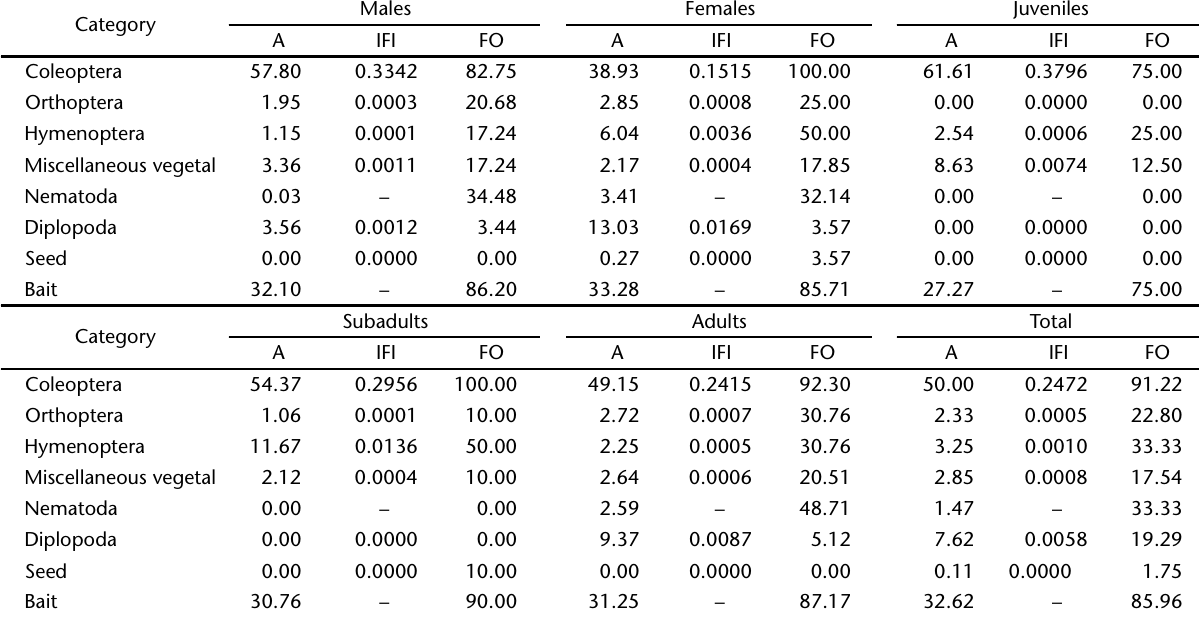
Table I. Diet categories of Monodelphis glirina in southern Amazon. (A) Abundance, (FO) Frequency of occurrence, (IFI) Importance food index.